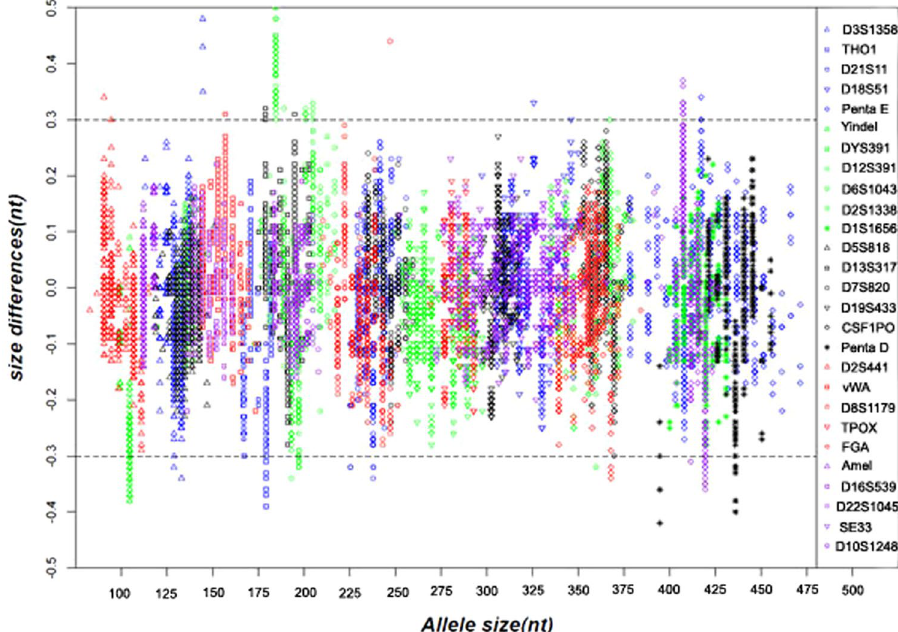
Figure 3. Size accuracy of the SureID PanGlobal system on Applied Biosystems 3500 XL Genetic Analyzer. Data points were collected from a total of 22815 alleles from 457 samples. The X-axis represents the nominal nucleotide sizes for the SureID PanGlobal allelic ladder mix. The dashed lines parallel to the X-axis represent the ± 0.3 nt windows. The Y-axis represents the deviation of each sample allele size from the corresponding size of allelic ladder. All sample alleles are within ± 0.5 nt from a corresponding allele in the allelic ladder